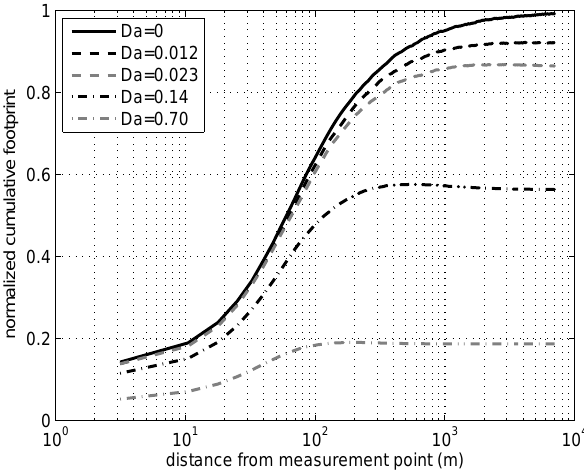
Fig. 1. Example of cumulative flux footprints for inert and reac- tive gases as calculated by the SLTC-model for height of 1.5 times the canopy height. The cumulative footprint of the inert compound (Da=0) approaches unity while the others are affected by the chem- ical